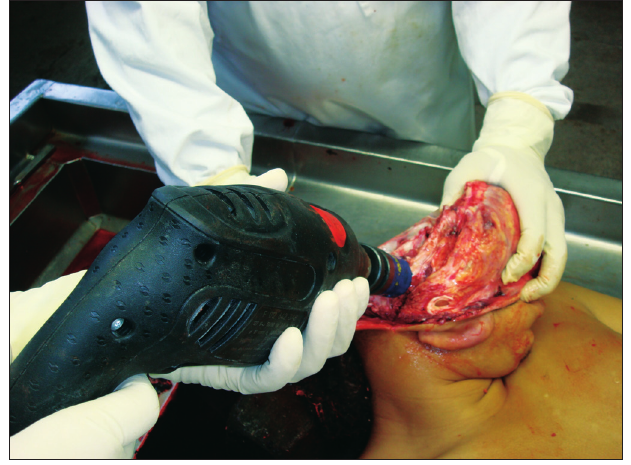
Figura 1. Orientação da furadeira e da broca para início do corte.